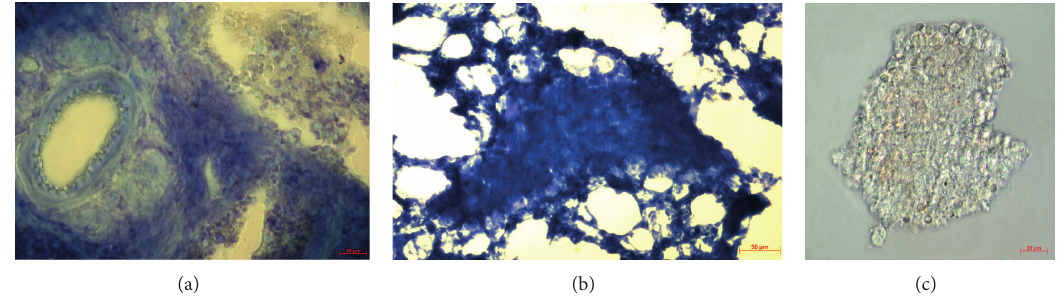
Figure 1: Solid granulomas (the central part of the image) in spleen (a) and lung (b) of BALB/c mice after one month of BCG infection were detected on histological sections with azure-eosin and methylene blue staining. (c) Phase contrast image of granuloma after isolation from mouse spleen. Scale bars: 20 𝜇 m ((a), (c)), 50 𝜇 m